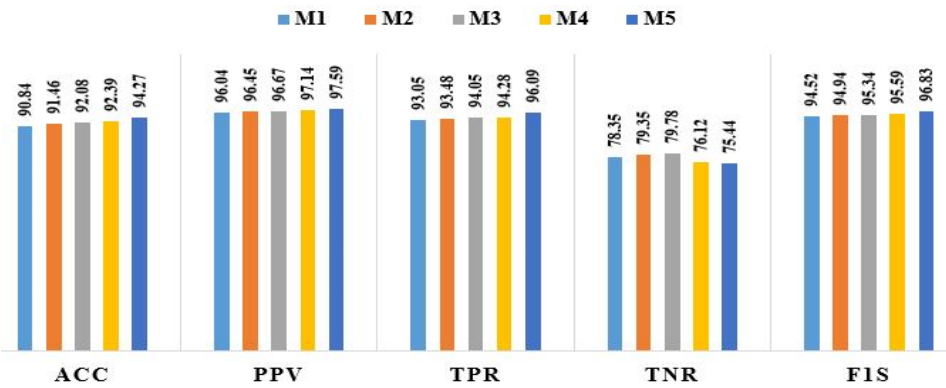
Figure 6. Results of several performance parameters based on different ML approaches were recorded.